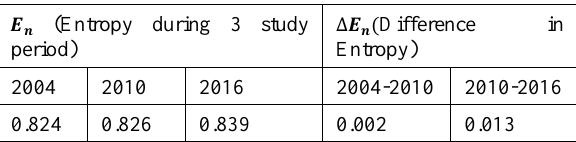
Table 3. Shannon's entropy value and change in